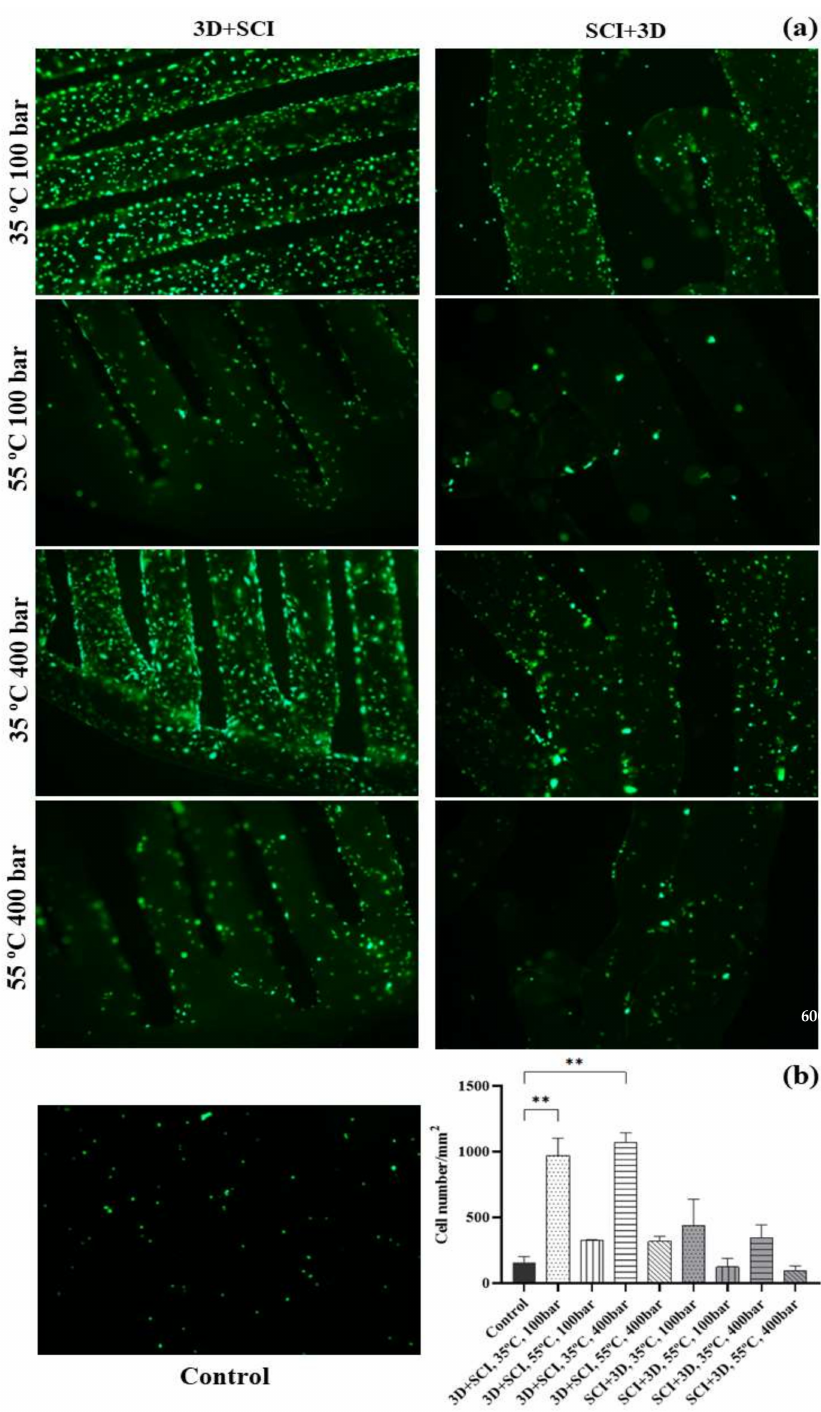
Figure 7. Viability of ECFCs grown on MLE impregnated PLA disks. ( a ) Representative images of ECFCs cultured on PLA disks impregnated with mango extracts under different sets of conditions, compared against a non-impregnated control disc. Calcein labeling can be observed (green dots) after incubation for 1 h at 37 ◦ C. The photographs were taken at 4 × magnification. ( b ) Graphical representation of the cell count per unit area under the different impregnating conditions of the PLA disks. The values are represented as mean ± SEM ( n = 3). ** p -value <